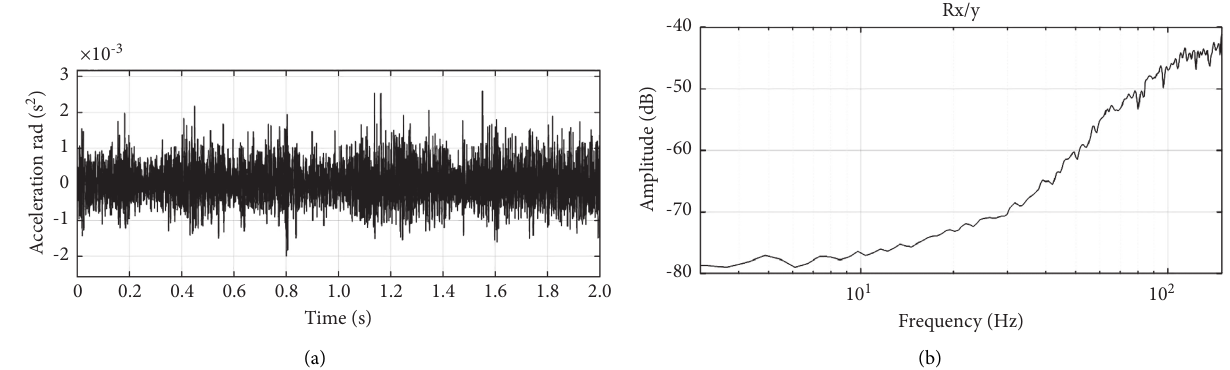
Figure 6: The coupling output of Rx when y is input direction. (a) Acceleration and (b) frequency domain